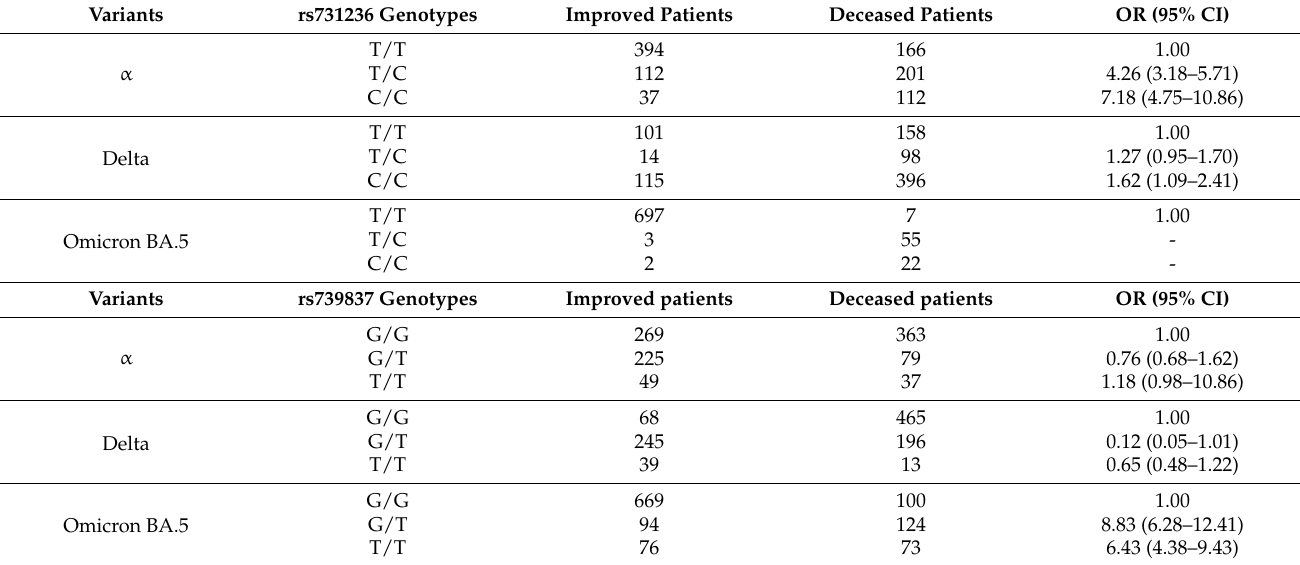
Table 3. Association between TaqI rs731236 and BglI rs739837 genotypes and mortality in COVID-19 patients stratified by SARS-CoV-2 variants.